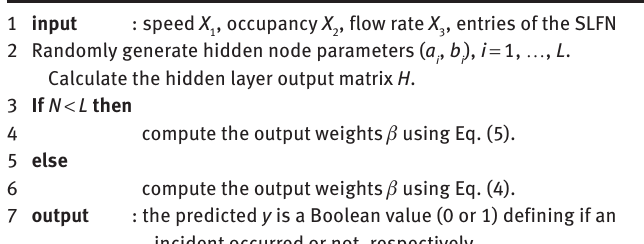
Algorithm 1: ELM Training